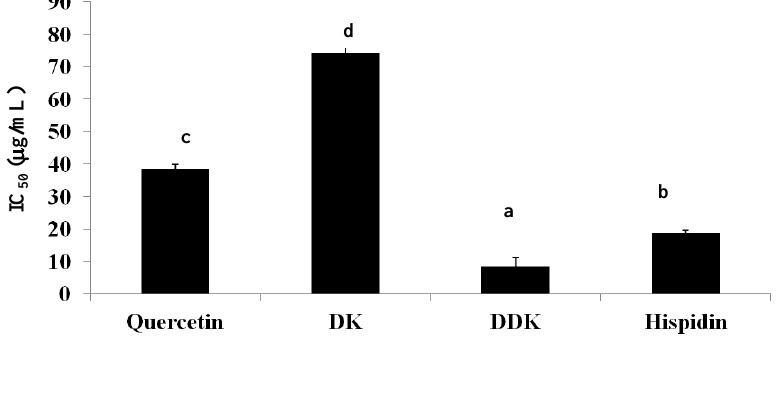
Figure 9. The effect of hispidin, DK and DDK on pancreatic lipase activity. Reported values are the mean ± SE ( n = 3). Letters with different superscripts indicate samples that are significantly different ( p < 0.05) than the